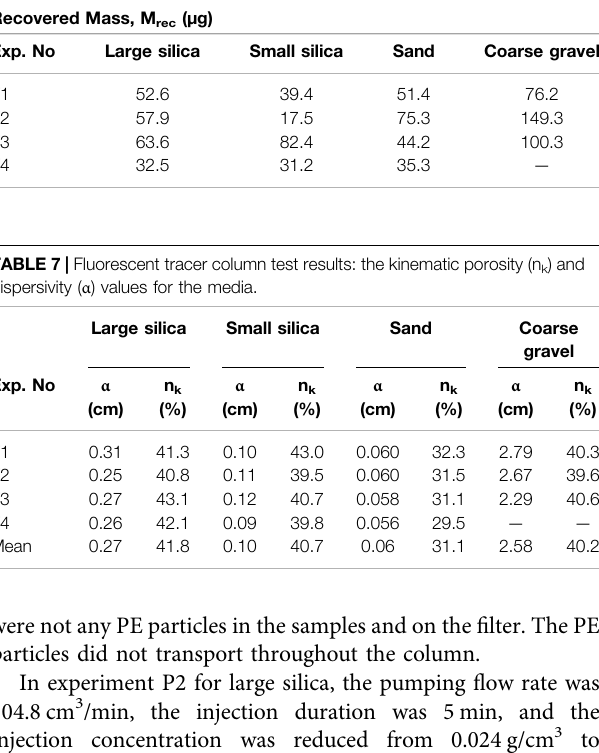
TABLE 6 | Fluorescent tracer column test results: Recovered Mass, M rec (µg). Recovered Mass, M rec (µg) Exp. No